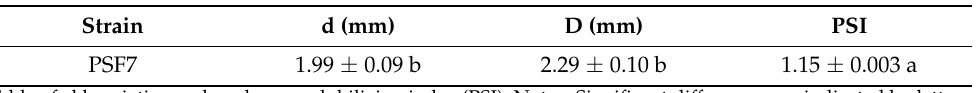
Table of abbreviations: phosphorus-solubilizing index (PSI). Notes: Significant differences are indicated by letters, same letters, no significant difference; different letters, significant